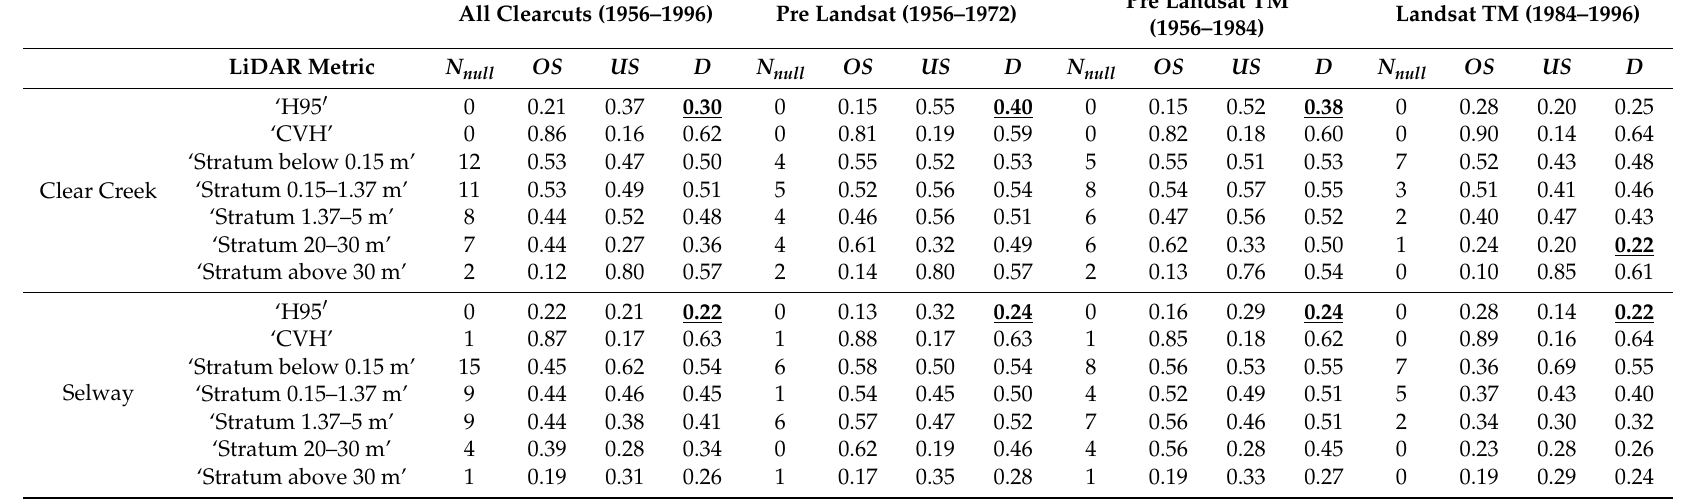
Table 4. Supervised selection of the optimal LiDAR metric. Area-based dissimilarity metrics of oversegmentation ( OS ), undersegmentation ( US ), and summary score ( D ) are presented for the optimal segmentation of the seven considered LiDAR metrics; the number of reference objects with no corresponding image objects is also reported ( Nnull ). Four scenarios, based on the age of clearcut of the Forest Service Activity Track System (FACTs) harvest reference polygons, are considered: All clearcuts (1956–1996), clearcuts performed before the start of the Landsat MSS record (1956–1972), clearcuts performed before the start of the Landsat TM record (1956–1984), and clearcuts performed after the start of the Landsat TM/ETM+ record (1984–1996). For each scenario, the D score value of the optimal metric is marked (bold and